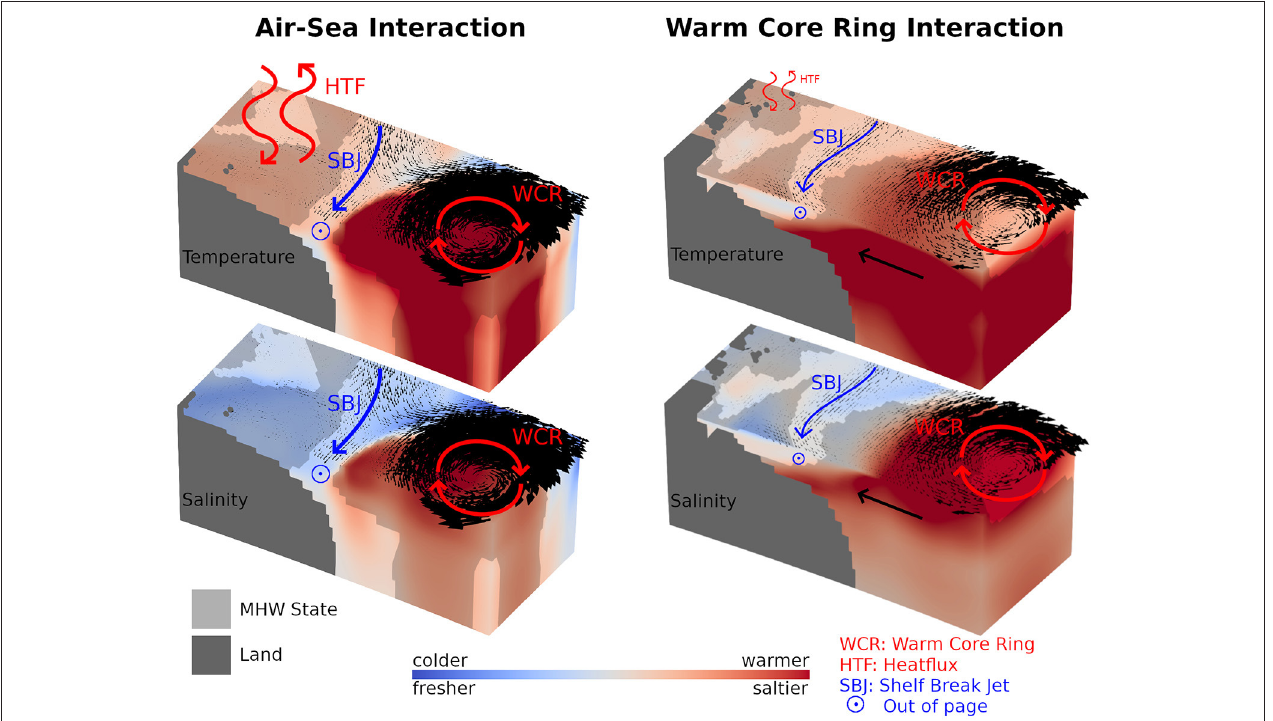
FIGURE 13 | Schematic of the two dominating MHW structures and related drivers in the region; shown are 3D fields of temperature and salinity anomalies with shaded MHW state, surface arrows indicate